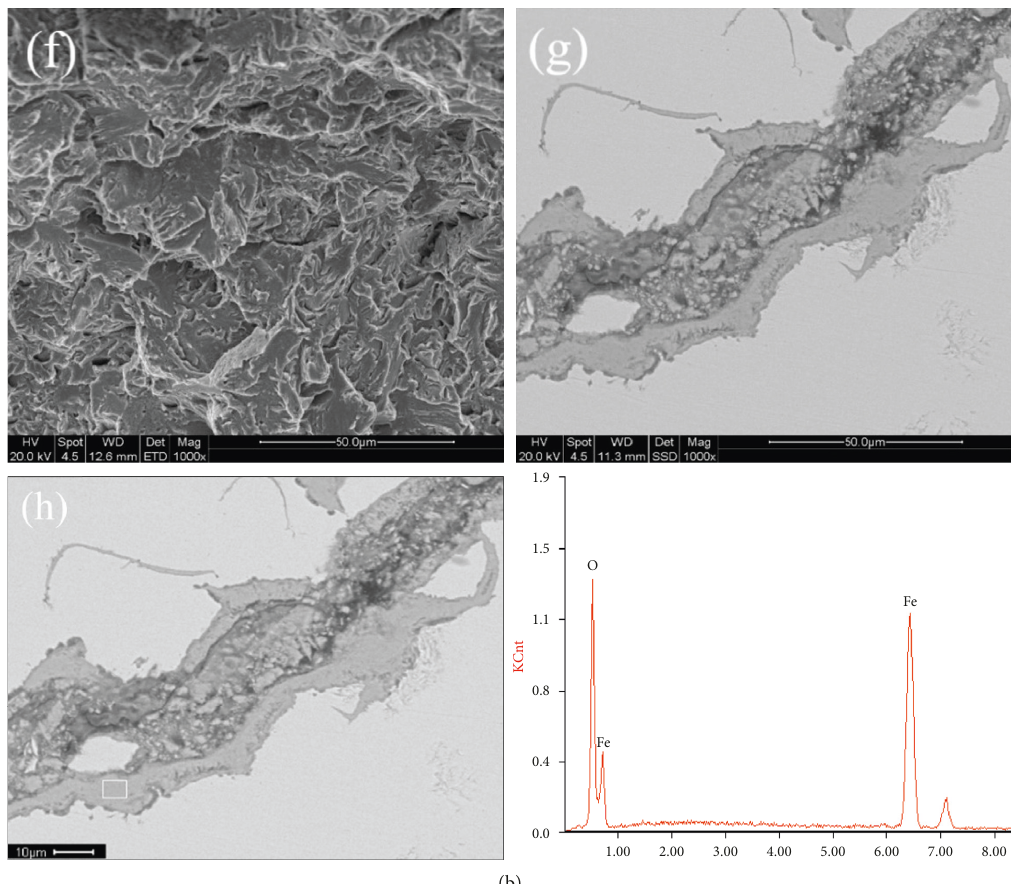
Figure 11: Scanning electron microscope analysis of Y -3. (a) The Y -3 crack. (b) Micromorphology of the crack surface. (c, h) Energy spectrum analysis. (d, e) Crack micromorphology. (f) Cleavage characteristic. (g) Local crack